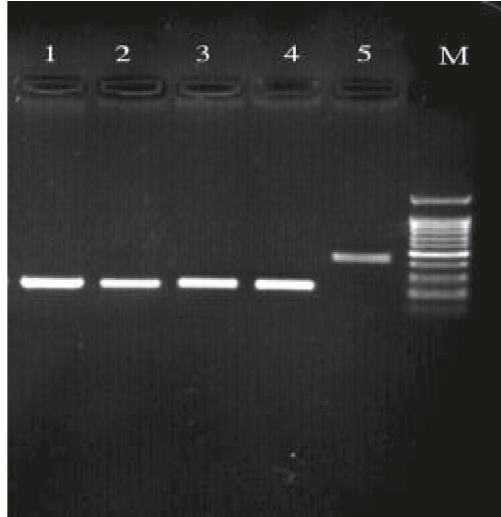
Figure 6: PCR product electrophoresis of 284bp lasB gene and 444bp exoS gene (lanes 1–3: positive samples 286bp, lane 4 positive control, lane 284: lasB gene, lane 5: positive sample of 444bp exoS , and lane M: marker 100bp).